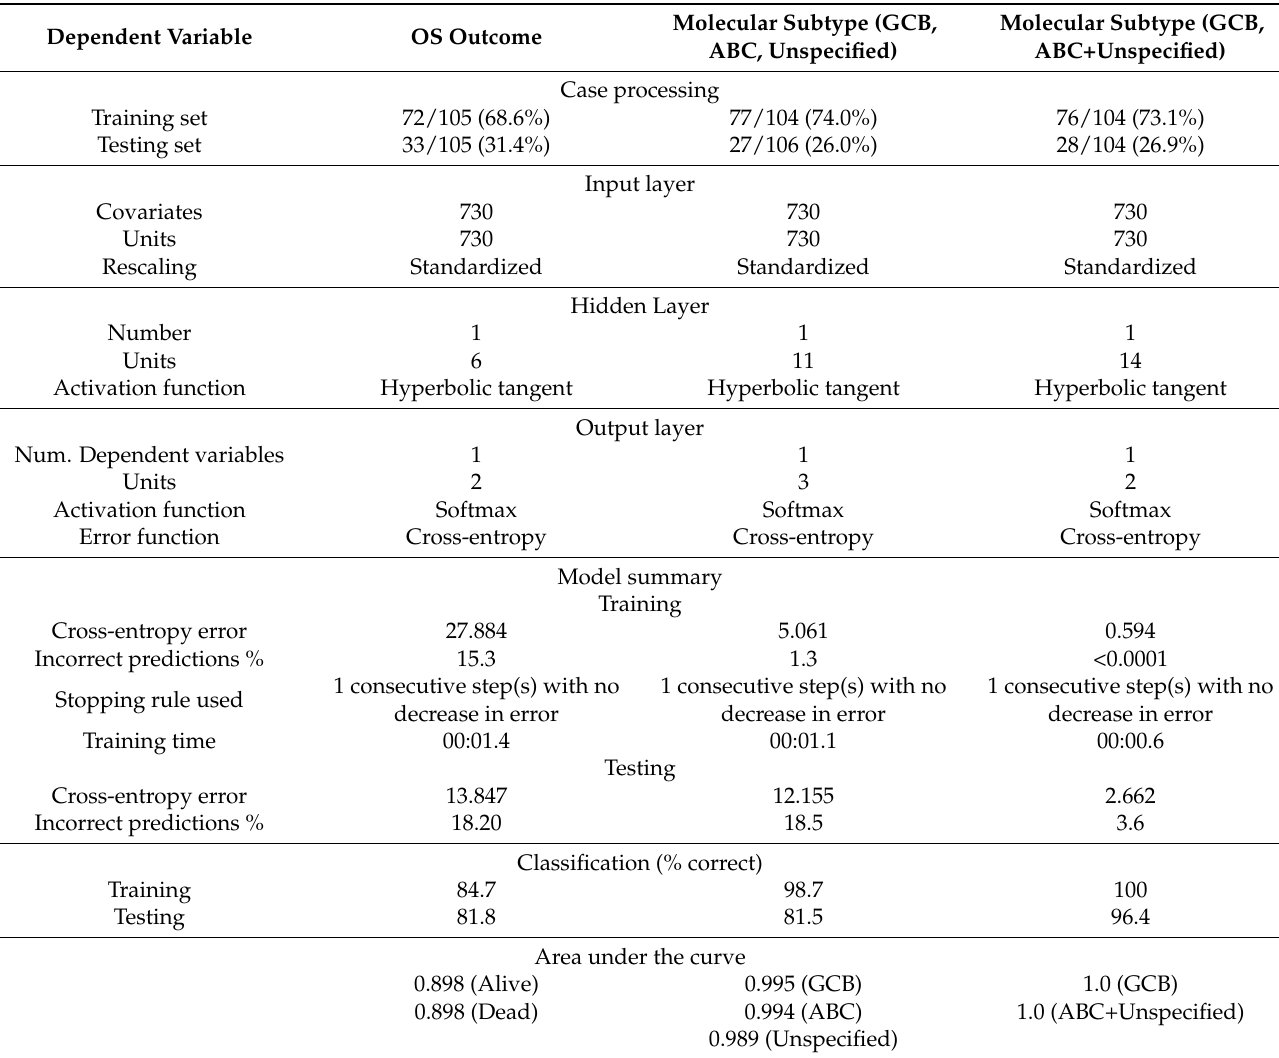
Table 1. Multilayer perceptron